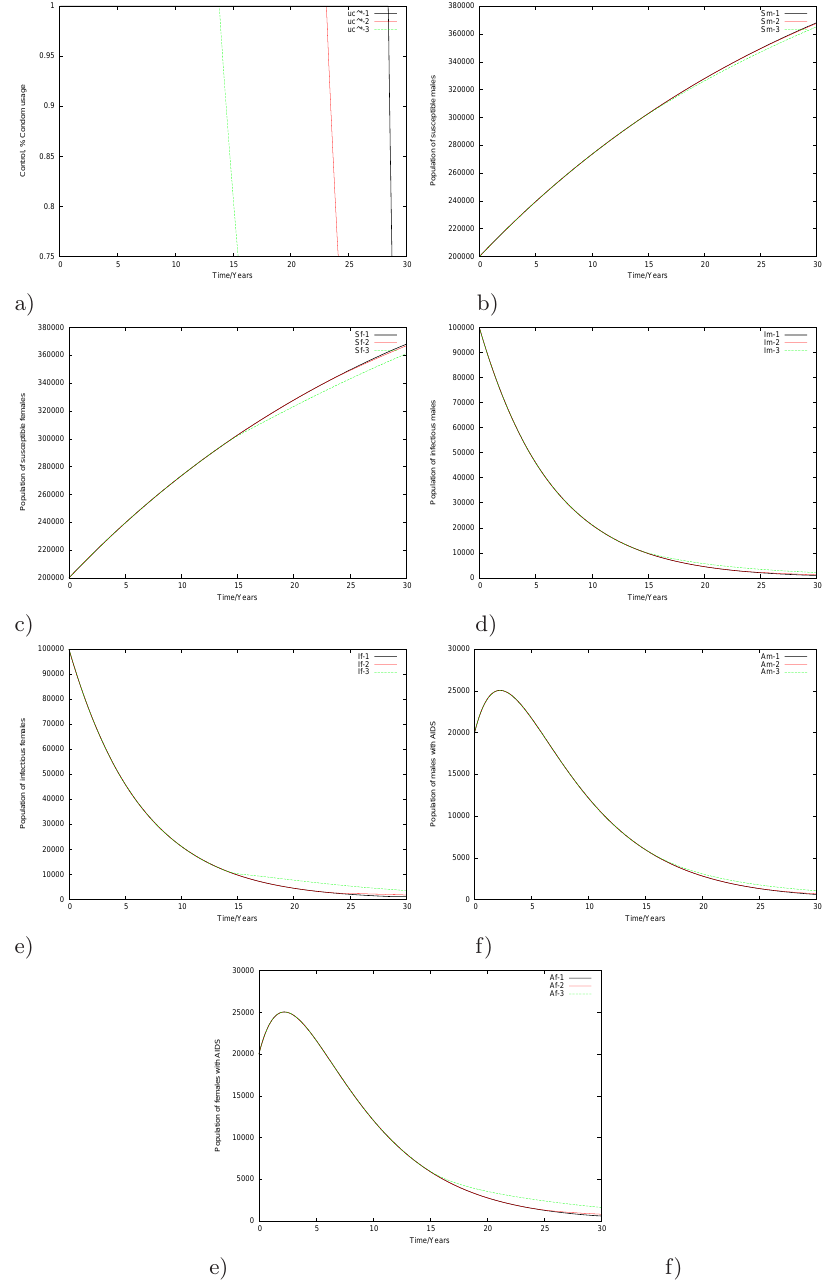
Figure 1. Graphs of the numerical solutions of the optimality system, showing propagation of (a) % condom usage, (b) susceptible males, (c) susceptible females, (d) infectious males, (e) infectious females, (f) male AIDS cases, and (g) female AIDS cases when condoms are used as an intervention for 30 years. The value of the weights used are (i) B 3 = 500 corresponds to variables with subscript 1, (ii) B 3 = 50000 corresponds to variables with subscript 2, and (iii) B 3 = 50 corresponds to variables with subscript